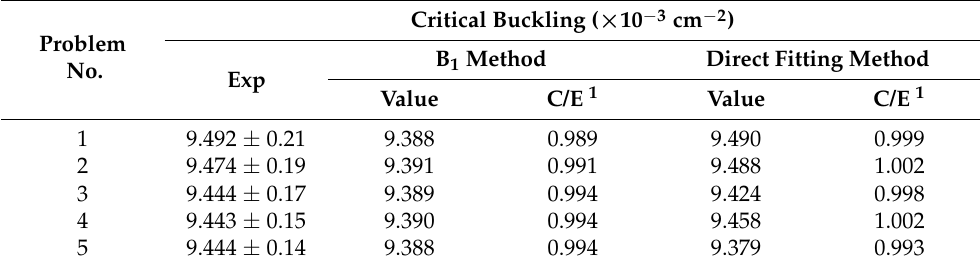
Table 4. Vertical extrapolation lengths of TCA experiment benchmark problems.